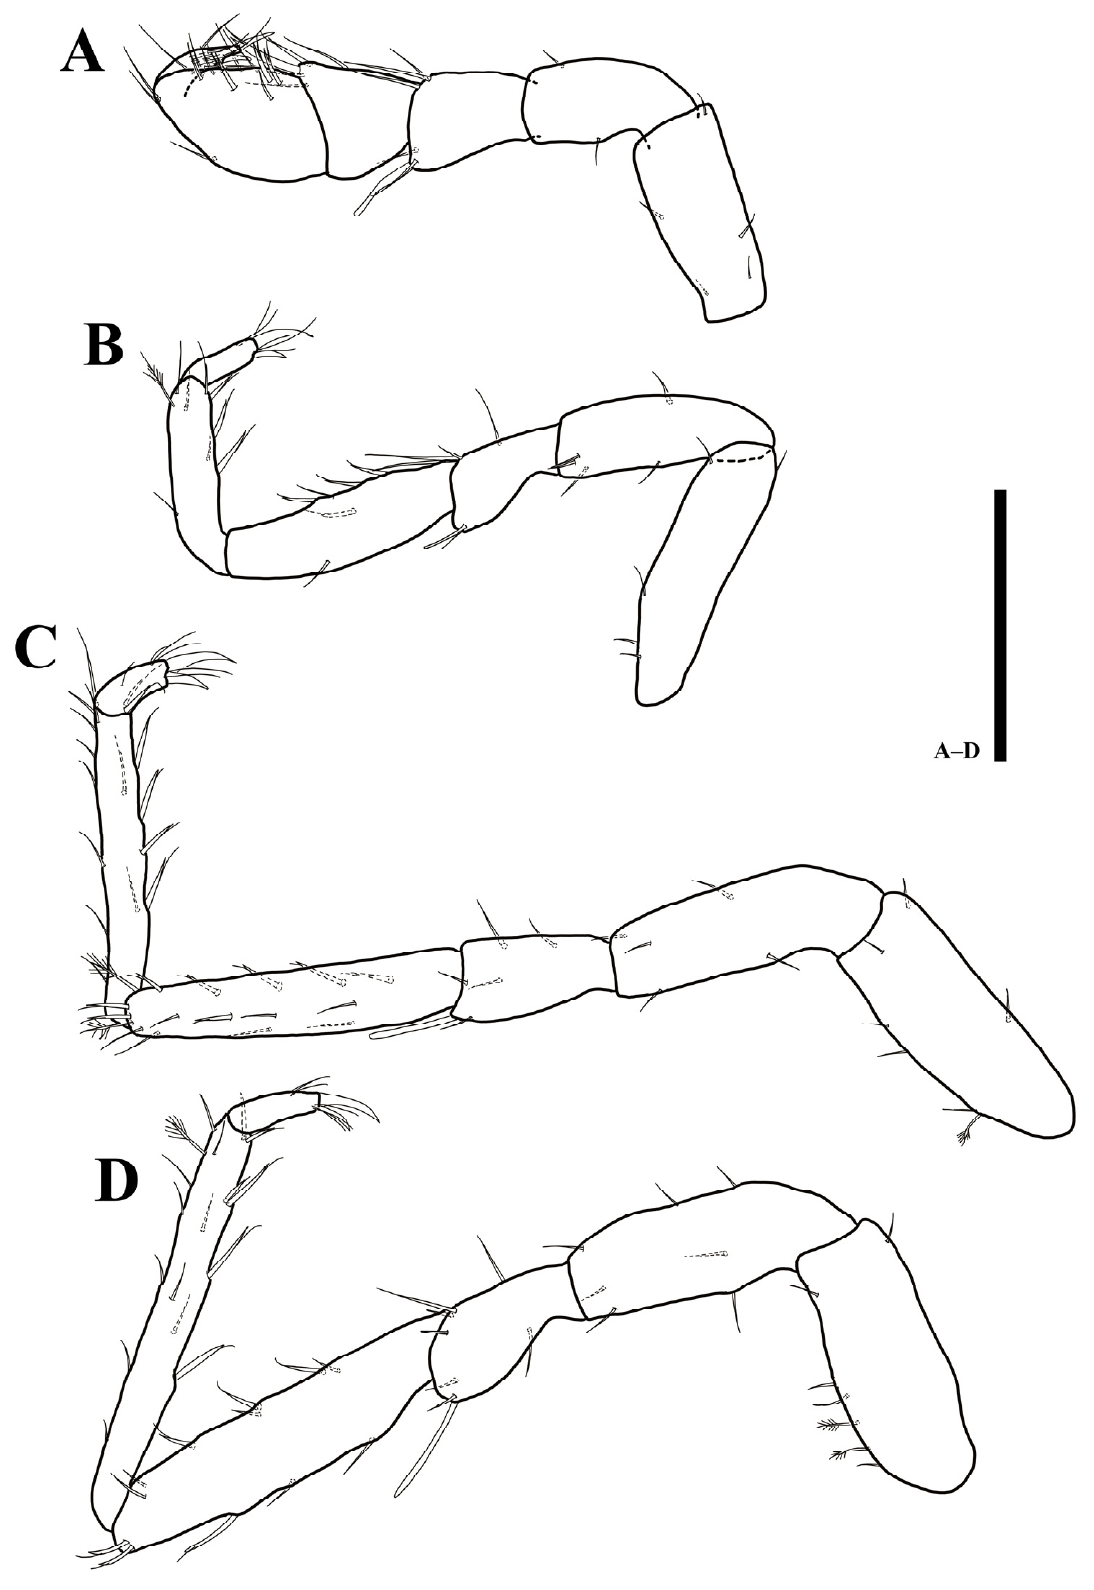
Figure 11. Uromunna jejuensis sp. n. holotype male: ( A ) pereopod 1; ( B ) pereopod 2; ( C ) pereopod 3; ( D ) pereopod 4. Scale bars = 100 μ m.